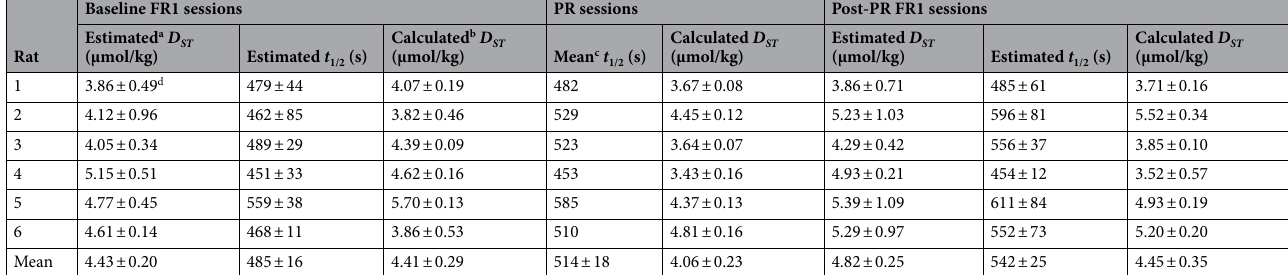
Table 1. Estimated and calculated cocaine D ST and estimated cocaine elimination half-life t 1/2 in individual rats. a Estimated using Eq. (2). b Calculated using the estimated half-lives. c Mean of Baseline FR1 and Post-PR FR1 sessions. d Mean ± SEM.